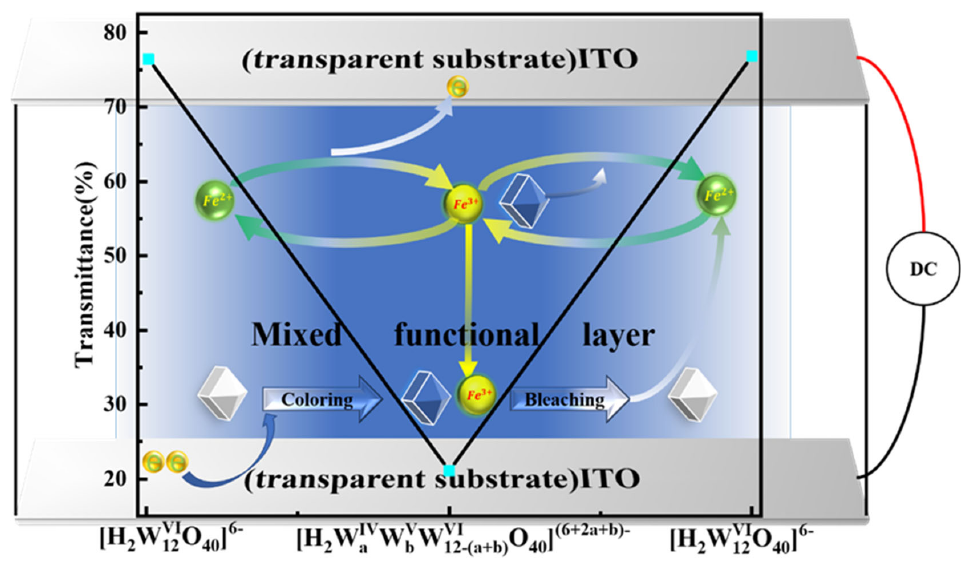
Figure 3. Reaction diagram of the mixed functional layer.